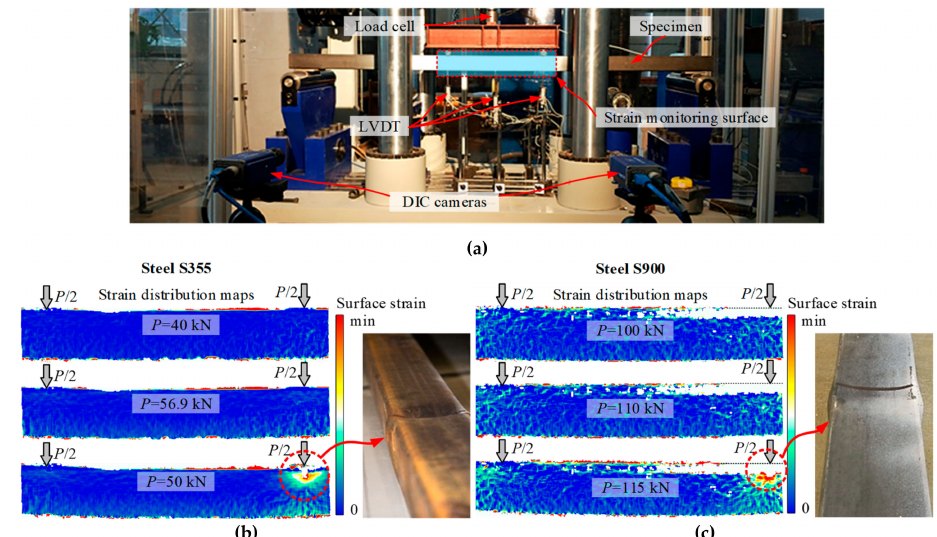
Figure 5. Deformation analysis of the SHS bending profiles: ( a ) loading sheme; ( b , c ) strain distribution maps identified by the digital image correlation (DIC) system and local failure of the NSS and HSS beam specimens.